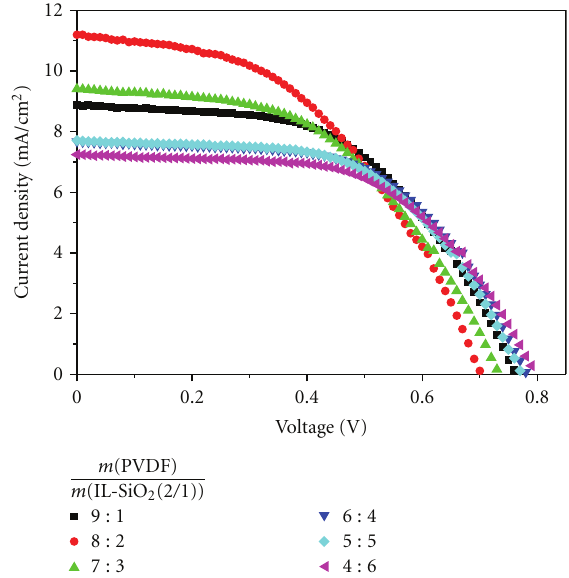
Figure 8: I–V curves of DSSCs with PVDF/IL-SiO 2 (1/1) GPEs. Figure 9: I–V curves of DSSCs with PVDF/IL-SiO 2 (2/1) GPEs.